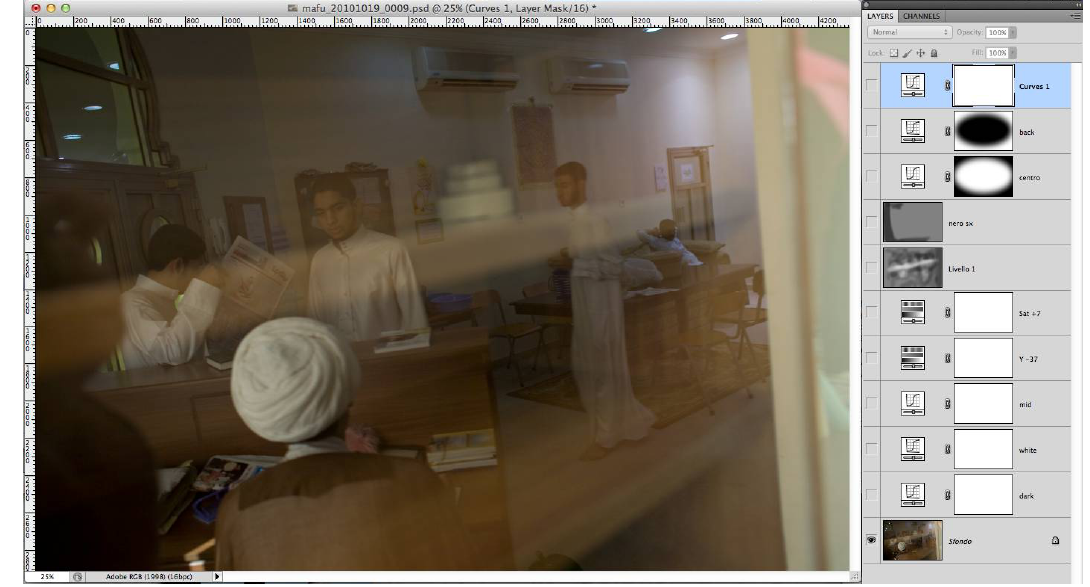
Figure 2. Un-designed photograph. All materials © Massimiliano Fusari/Massimedia. Visual journalism before (above in Figure 2) and after (below in Figure 3) digital designing of RAW